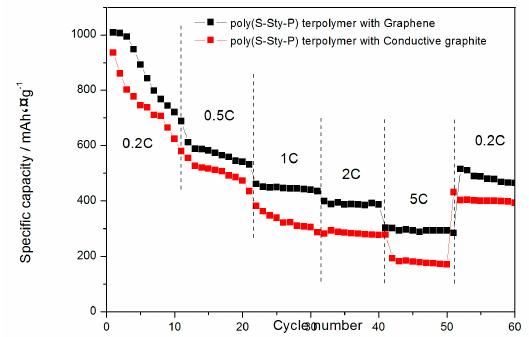
Figure 12. The rate performance of poly(S-Sty-P) terpolymer @ CCB battery and poly(S-Sty-P) terpolymer @ GF battery.